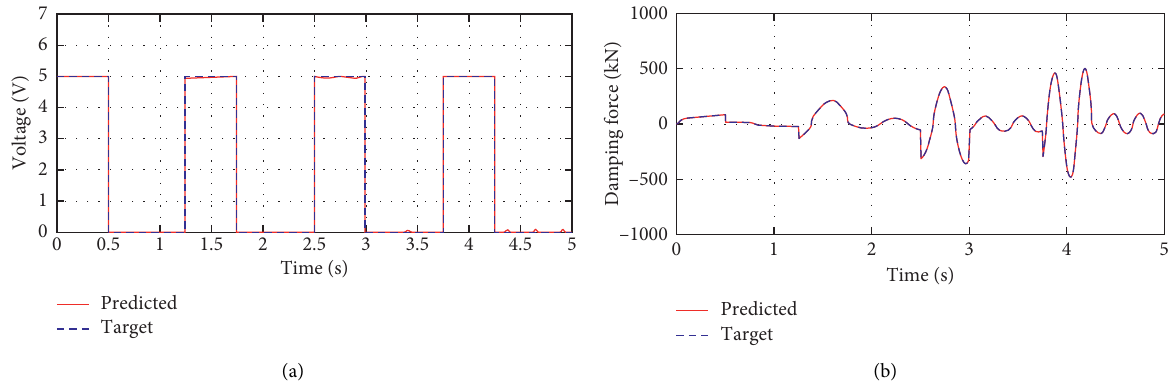
Figure 6: Predicted and target voltages (damping forces) for validation dataset I.